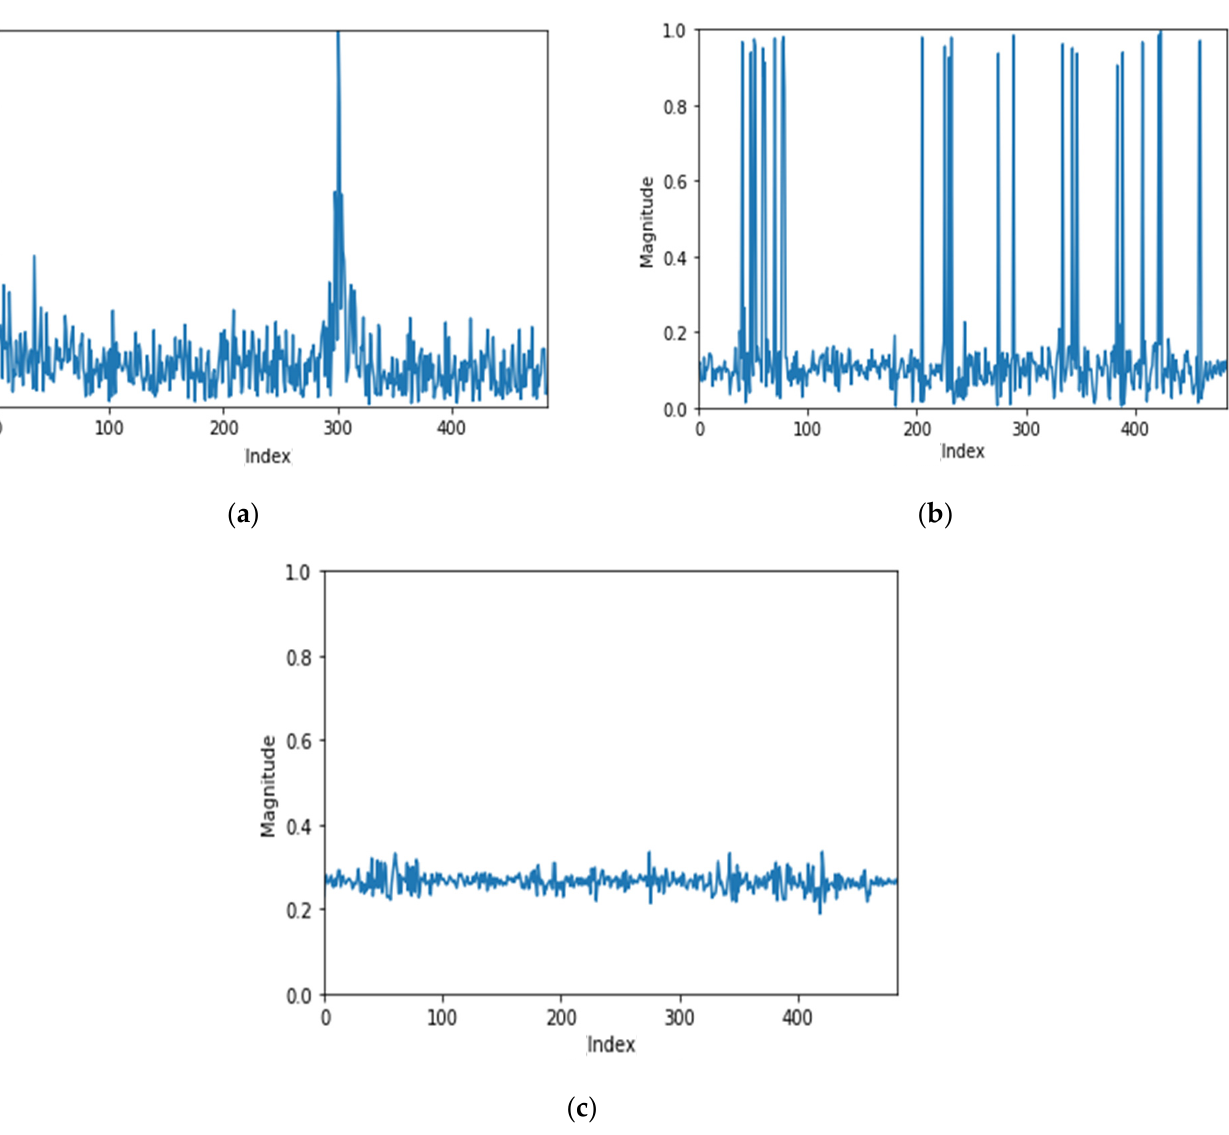
Figure 2. Normalized FFT data. ( a ) Normalized FFT ( x -axis data), ( b ) normalized FFT ( y -axis data), and ( c ) normalized FFT ( z -axis data).